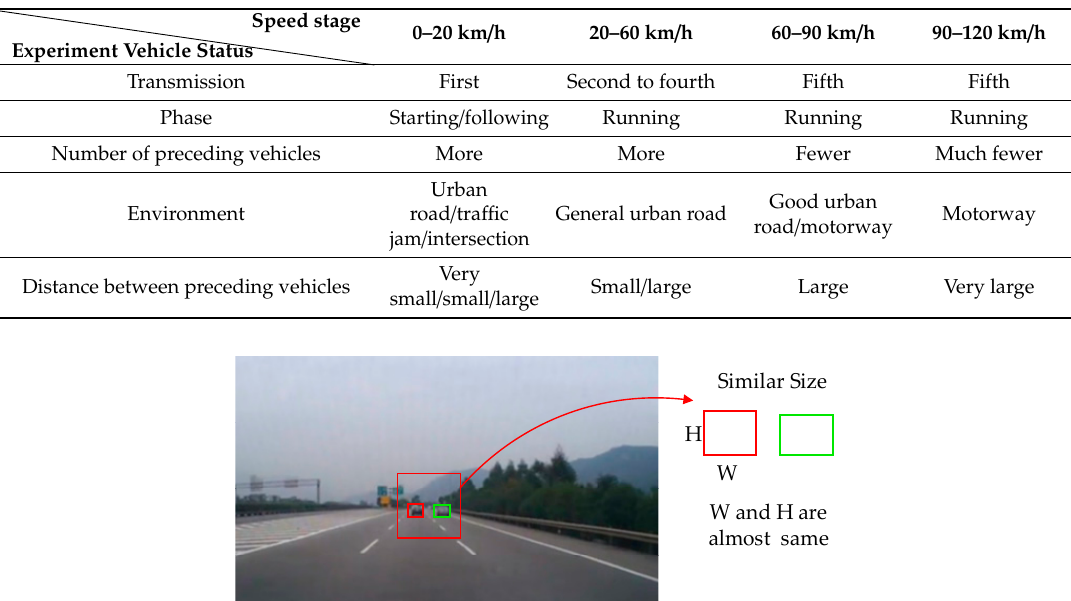
Table 2. Status of experimental and preceding vehicles at di ff erent speed stages.